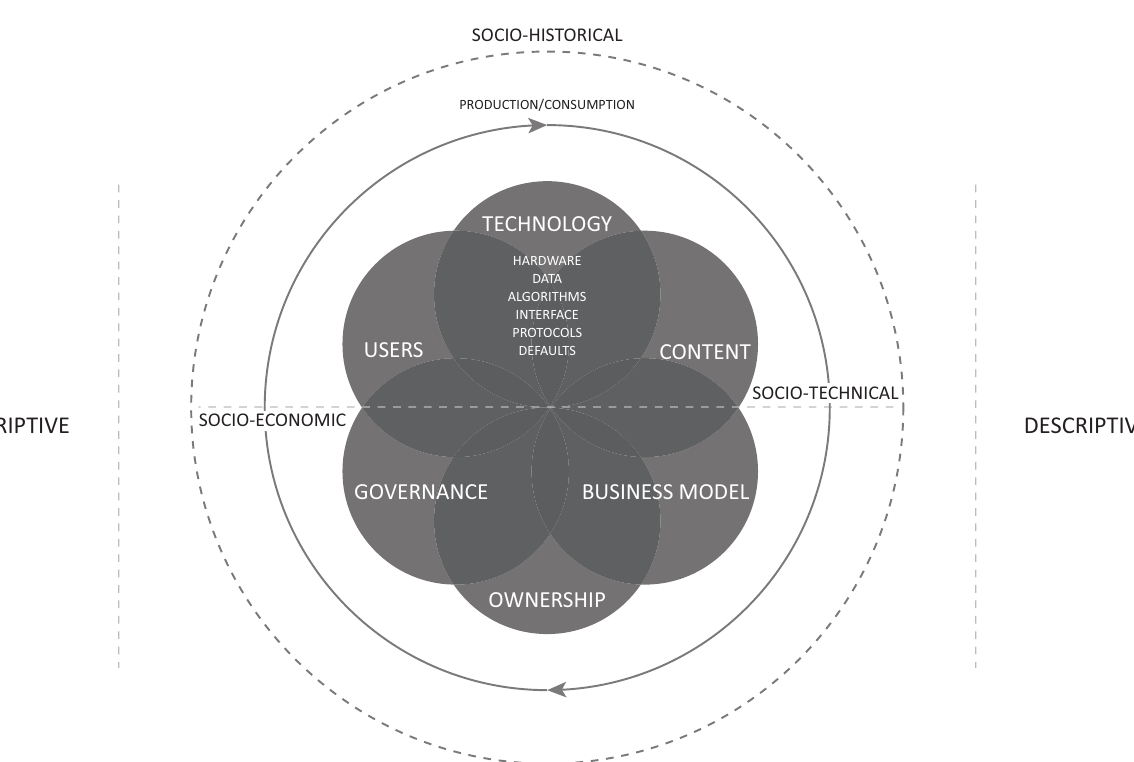
Figure 5. An expanded model for digital literacy research that includes socio-technical, socio-economic, and socio-historical